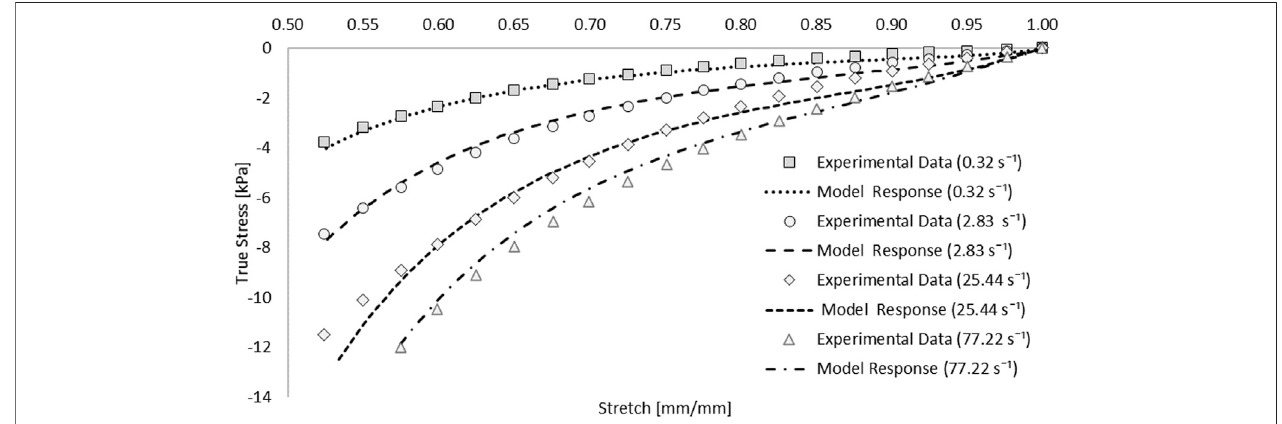
FIGURE4| Optimizedresponseofthehyper-viscoelasticOgdenmaterialmodelinsingleelementtestcasescomparedtouncon fi nedcompressiontestdataofthe spinal cord tissue (Jannesar et al., 2018).